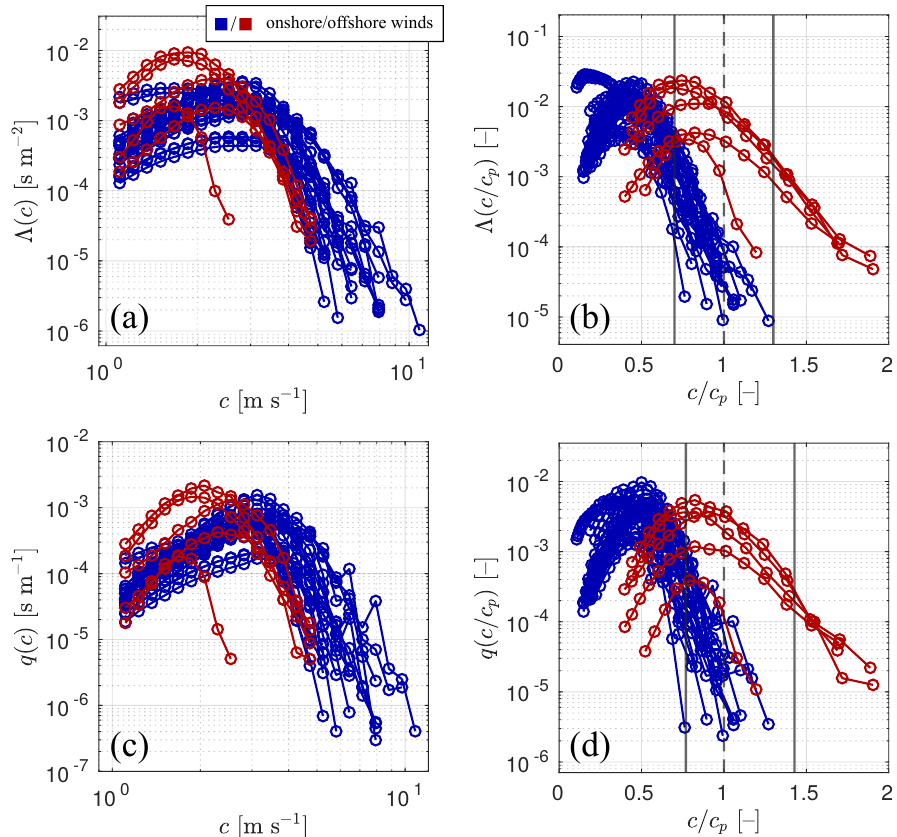
Figure 5. ( a , b ) The Λ distributions as a function of c and c / c p , where c p is the peak phase speed. ( c , d ) The same, but for q